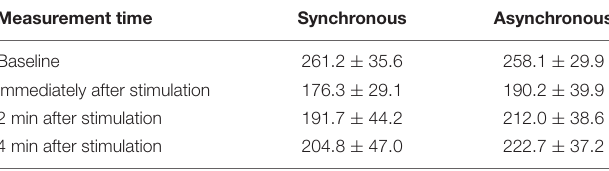
FIGURE 2 | Questionnaire results: Boxes display interquartile data (IQR). Whiskers represent either extra data points or extend to 1.5 times IQR. Median and Mean are represented as horizontal lines and crosses within the box, respectively. The small circle denotes the outlier outside the whisker. ∗∗ p < 0.01. TABLE 2 | Finger position judgment task (proprioceptive drift data). Measurement time Synchronous